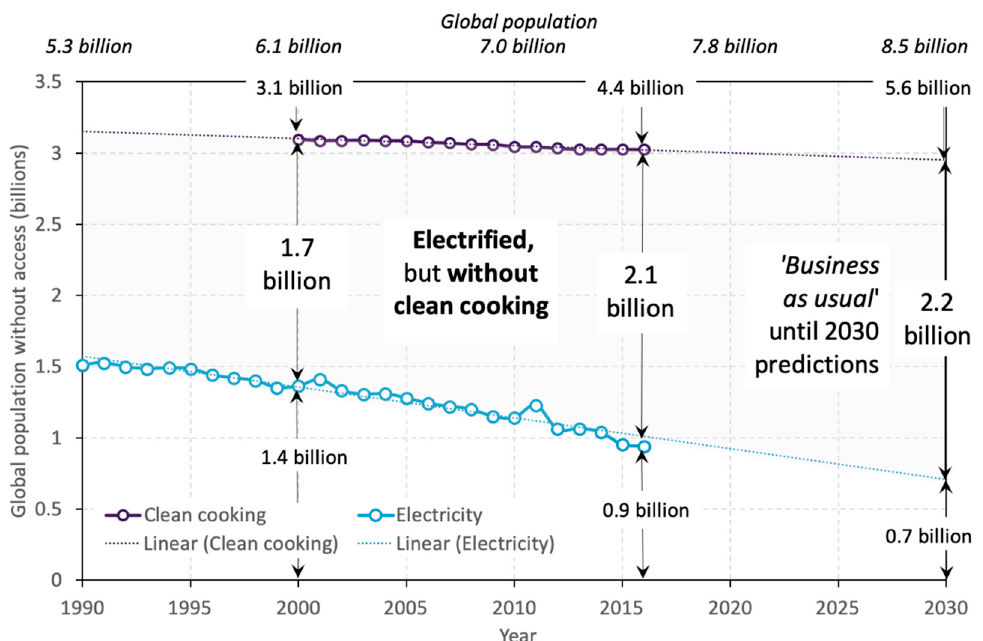
Figure 2. Trends in global access to electricity and clean cooking. Historical electrification, clean cooking and global population data sourced from the World Bank’s World Development Indicators (WDI) [25]. Future population predictions sourced from United Nations World Population Prospectus